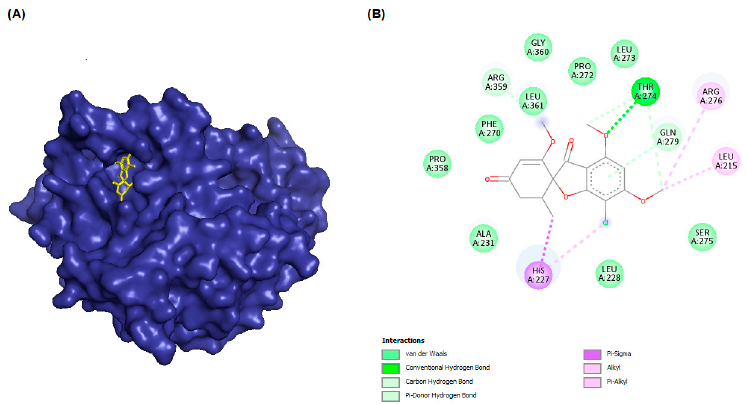
Figure 1. ( A ) The 3D griseofulvin binding pose (yellow), and ( B ) griseofulvin interactions at the active site of TUBB5 (blue). Images were captured by PyMol and Discovery Studio, respectively.